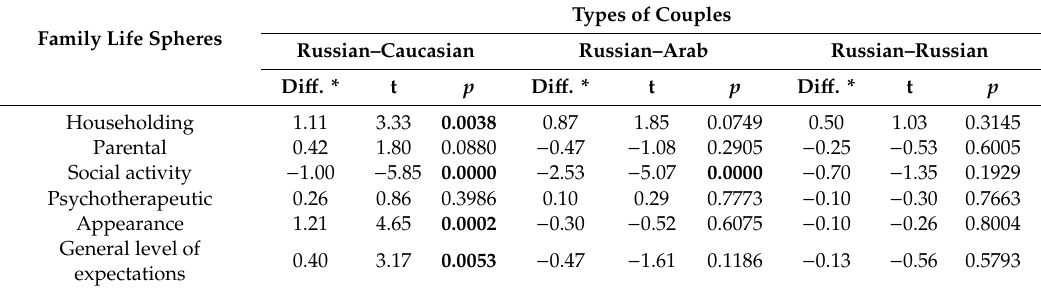
Table 5. The consistency of role expectations (expectations from the spouse of taking responsibility for the spheres of family life) of spouses in di ff erent types of couples. Family Life Spheres